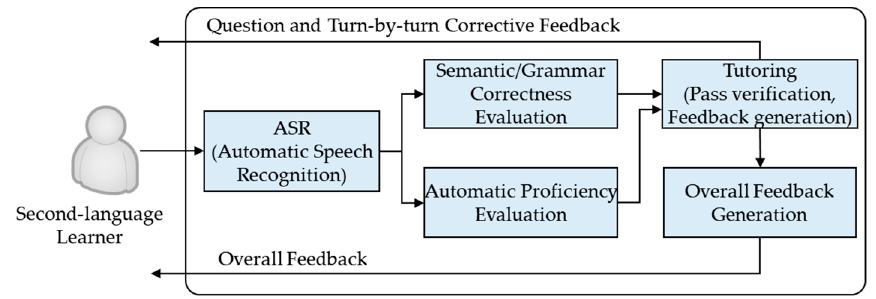
Figure 1. Schematic diagram of the GenieTutor system